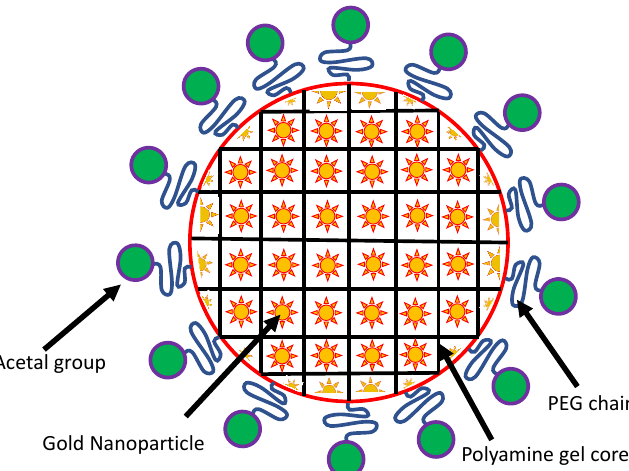
Figure 2. Schematic representation of the AuNP nanogel. The AuNPs are embedded in a core of polyamine gel, which are PEGylated with terminal acetal groups.